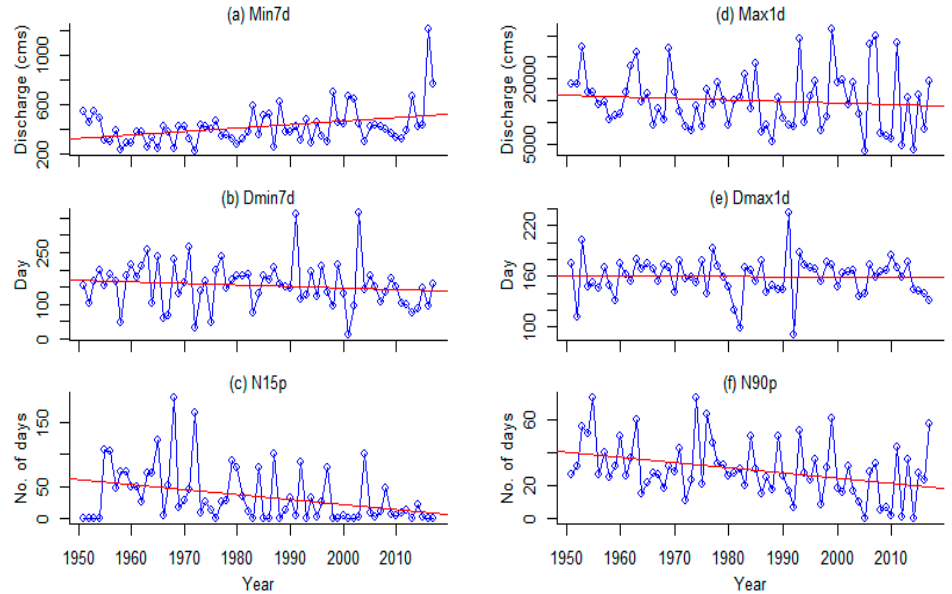
Figure 3. Changes of low flows and flood flows observed at Zhuqi during 1950 to 2017. ( a ) The annual series of minimum 7-day average discharge (Min7d); ( b ) minimum 7-day average flow occurrence time (Dmin7d); ( c ) the number of days with the discharge below the 15% percentile (~510 m 3 /s) (N15p); ( d ) maximum 1-day average discharge (Max1d); ( e ) maximum 1-day average flow occurrence time (Dmax1d); ( f ) the number of days with the discharge exceeding the 90% percentile (~3470 m 3 /s) (N90p). Table 2. Trend and change-points in flow series detected by the MK test and Pettitt